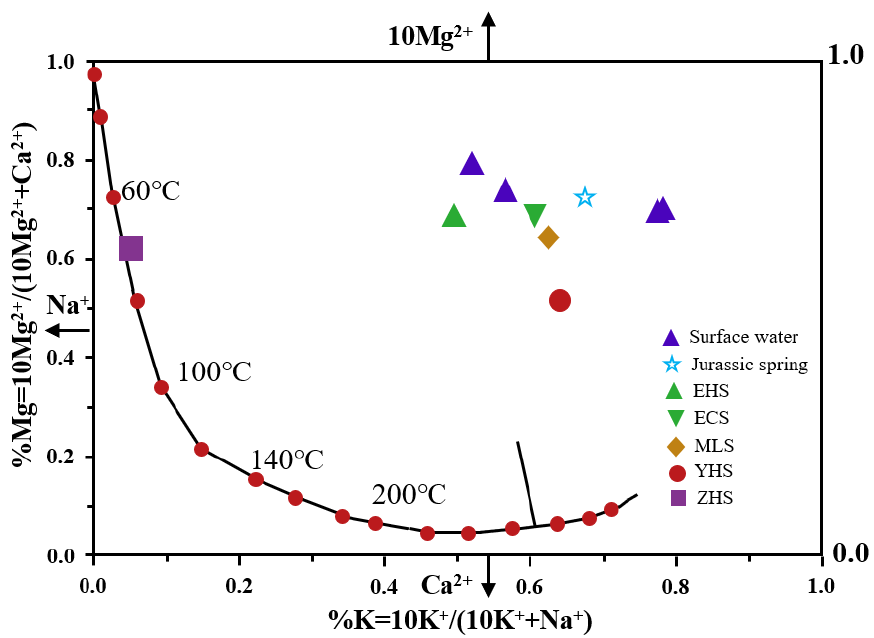
Figure 6. Na-K-Mg-Ca groundwater – rock balance diagram.